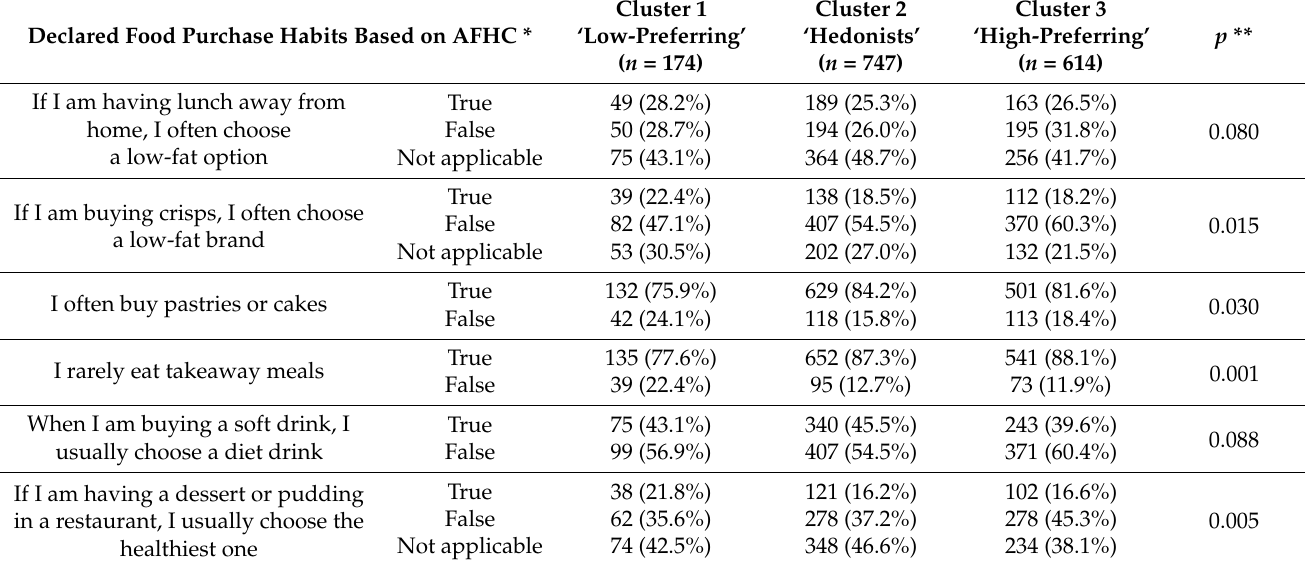
Table 6. The declared food purchase habits assessed based on the Adolescents’ Food Habits Checklist (AFHC) in the clusters stratified based on the preferences assessed while using the Food Preference Questionnaire (FPQ) within the female population of the second phase of the Polish Adolescents’ COVID-19 Experience (PLACE-19) Study ( n =